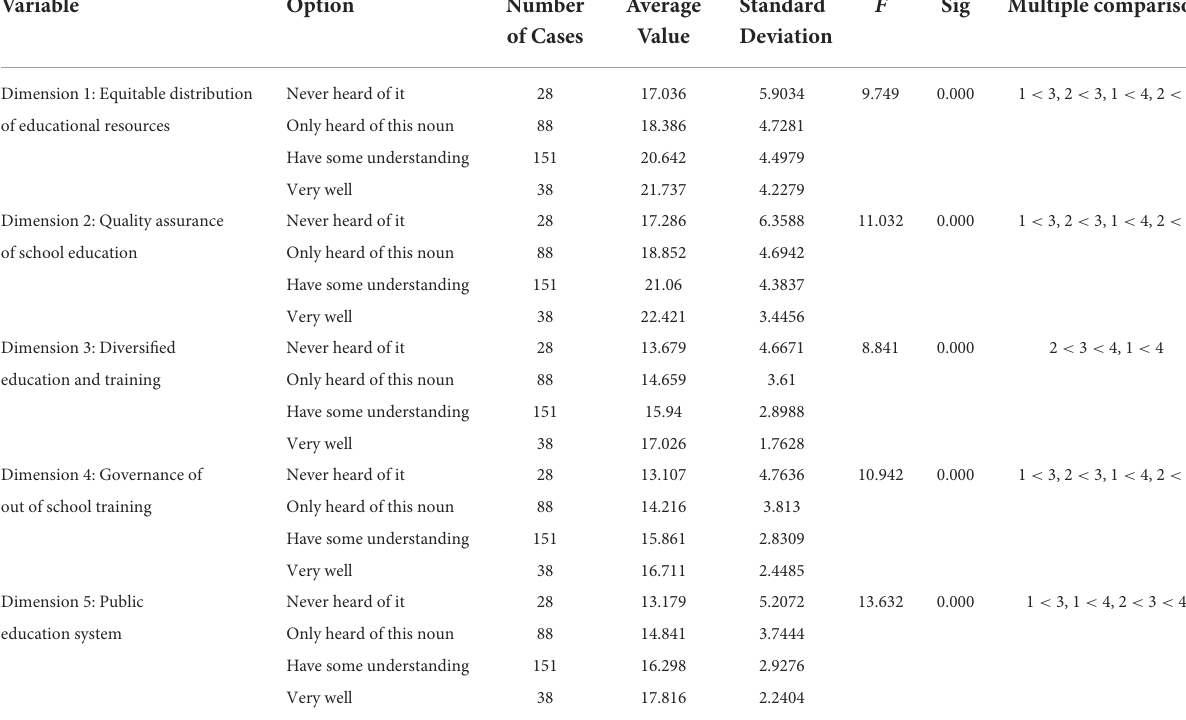
TABLE 13 Analysis of differences in understanding of the double reduction policy among data of various dimensions. Variable